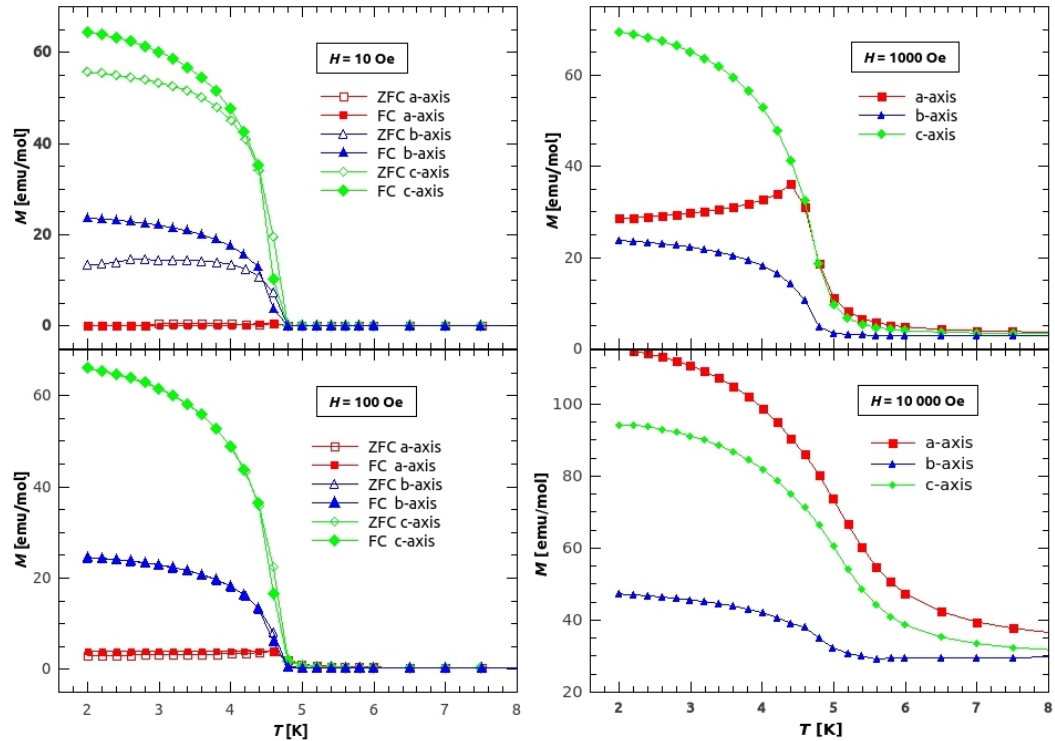
Figure 5. Temperature dependence of magnetization of single crystal GuaCuF in different fields. The magnetization was measured along the applied field. Red rectangles represent magnetization measured along the a -axis, blue triangles along the b -axis, and green diamonds along the c -axis. Empty/filled symbols stand for ZFC/FC curves, respectively. On Figure 5, the low temperature magnetization along different crystal axes is shown. On the left side, magnetization measured in 10 and 100 Oe of applied field is